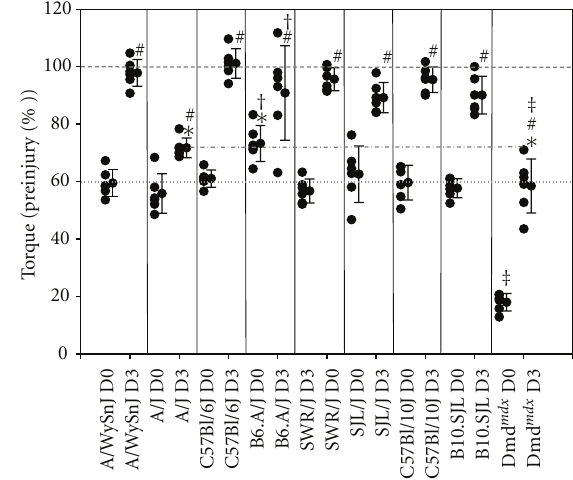
Figure 2: Torque after LSI. We measured maximum isometric torque ∼ 4 min after the last lengthening contraction in the LSI protocol (D0) and again 3 days later (D3). All control strains lost a similar level of torque. All dysferlin mutant mice except B6.A/J showed a similar reduction in torque immediately after injury; B6.A/J mice showed less susceptibility to initial injury compared to control C57Bl/6J mice as well as other dysferlinopathic strains. DMD mdx mice showed the highest level of torque loss immediately after injury. At D3, all control strains recovered to near baseline torque levels. All dysferlin mutants except A/J recovered to similar levels as their respective control strains. A/J mice and DMD mdx mice showed a significant torque deficit at D3. ∗ Significant di ff erence compared to control strain at same time point. # Significant di ff erence within same strain between D0 and D3. † Significant di ff erence compared to same Dysf mutation at same time point. ‡ Significant di ff erence compared to A/J at same time